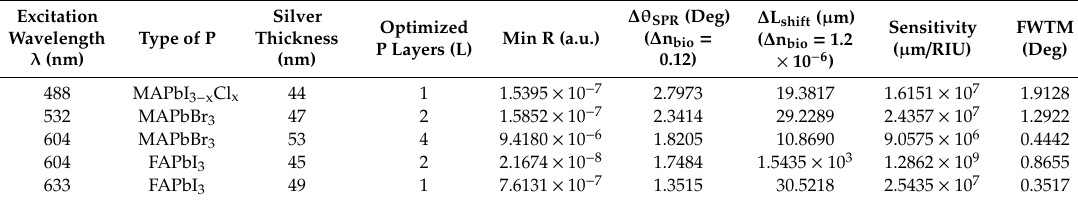
Figure 8. SPR signal changes for 2D perovskites (FAPbI 3 ) layer, in addition to the Goos–Hänchen (GH) shift: ( a ) optical phase; ( b ) resonance angle; ( c ) curve width; ( d ) minimum value of the reflectivity at the resonance angle. Table 3. Summary of the conditions for each type of 2D perovskite to achieve the largest Goos– Table 2. List of the parameters for the 2D perovskites with the best GH-SPR sensing performances for Hänchen lateral shift while simultaneously with high resolution. the four di ff erent excitation wavelengths ranging from 488 to 633 nm.